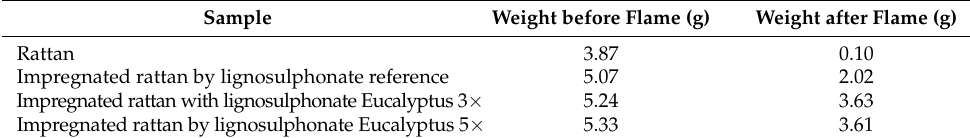
Table 10. Flammability test of rattan with torch gas for 2 min.